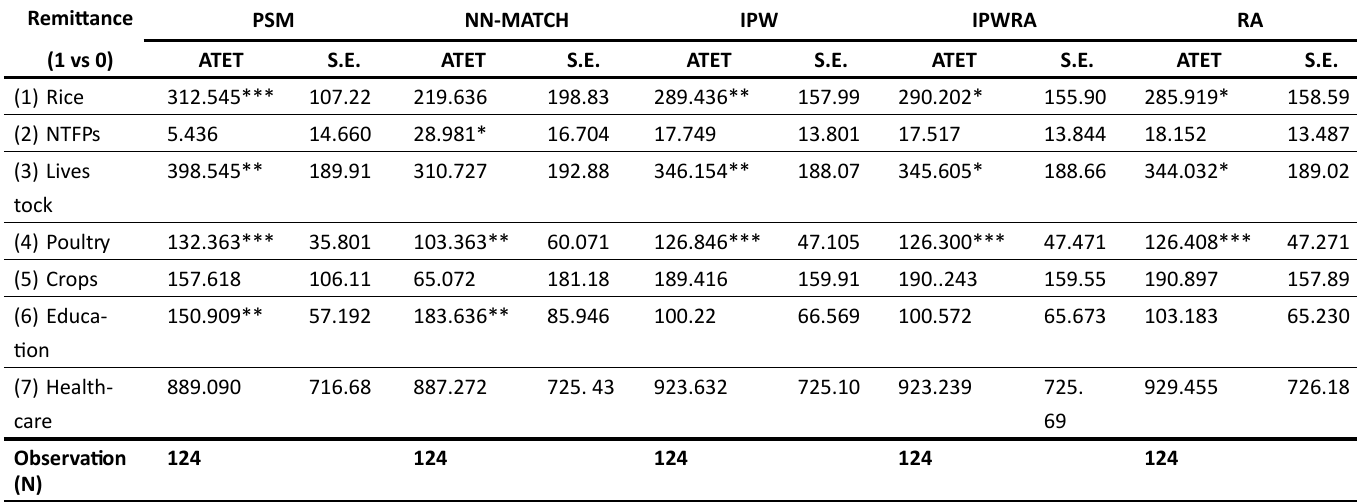
Table 9: ATET Estimation: Impact Of Remittances On Consumptions